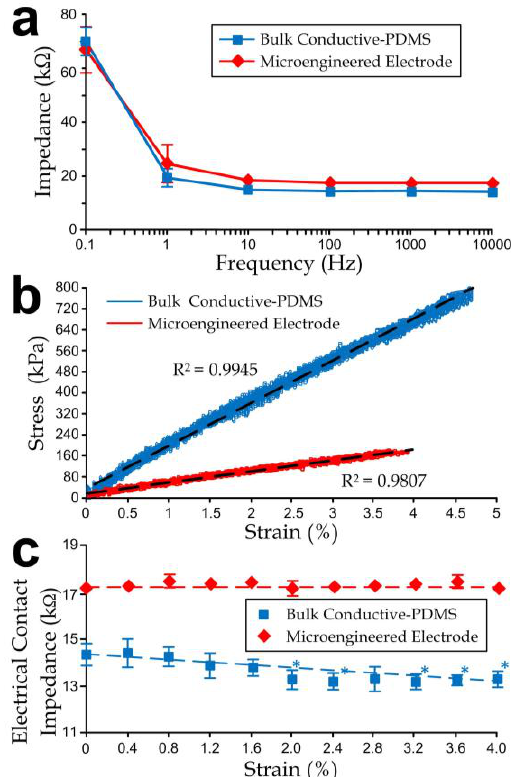
Figure 4. ( a ) Impedance curves of bulk and microengineered electrodes as functions of signal frequencies; ( b ) Stress-strain curves and ( c ) Electrode contact impedance of the electrodes as functions of tensile strains. The asterisks indicate significant changes ( p -value < 0.05) from the unstretched case, i.e ., the impedance at strain = 0%, using the Student’s t -test. All error bars in sub-figures represent standard